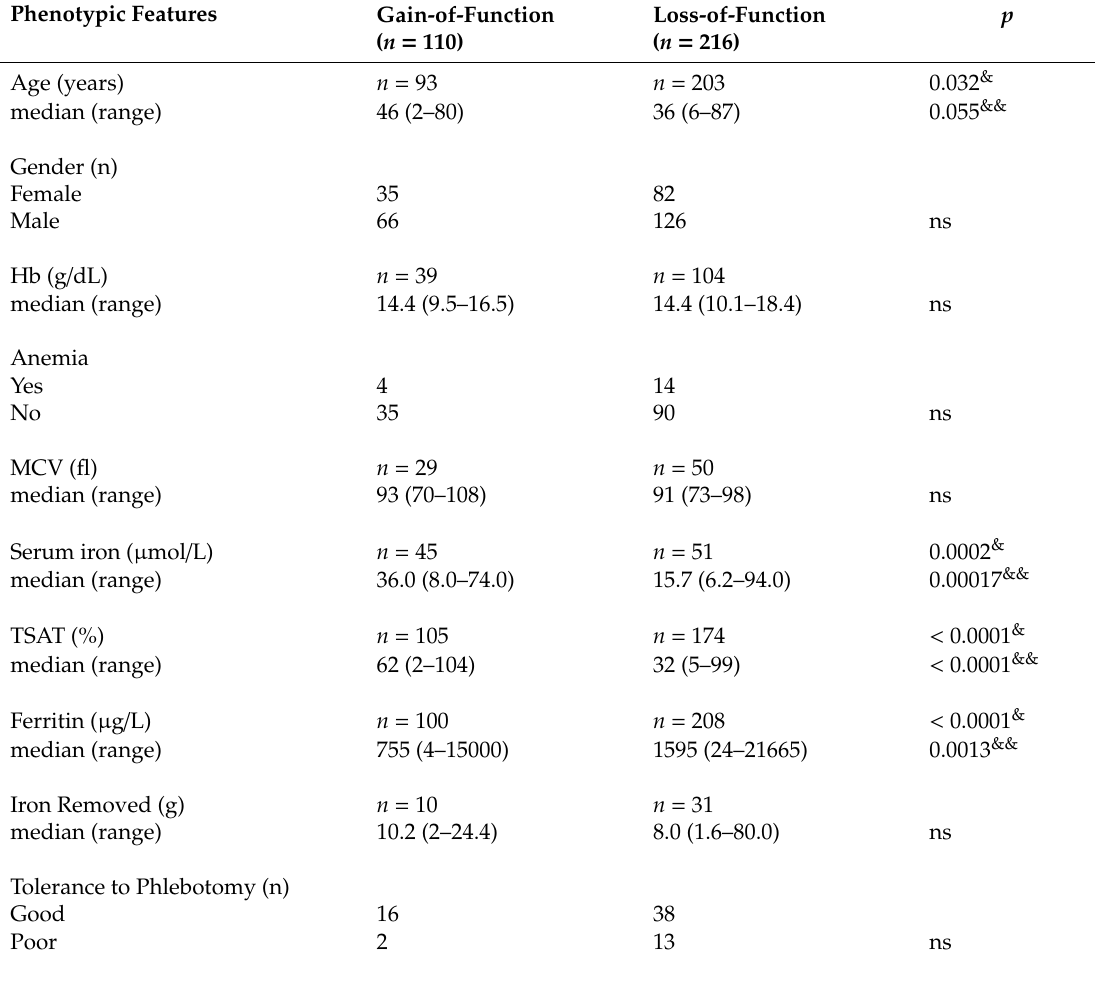
Table 3. Phenotypic features by ferroportin functional gene